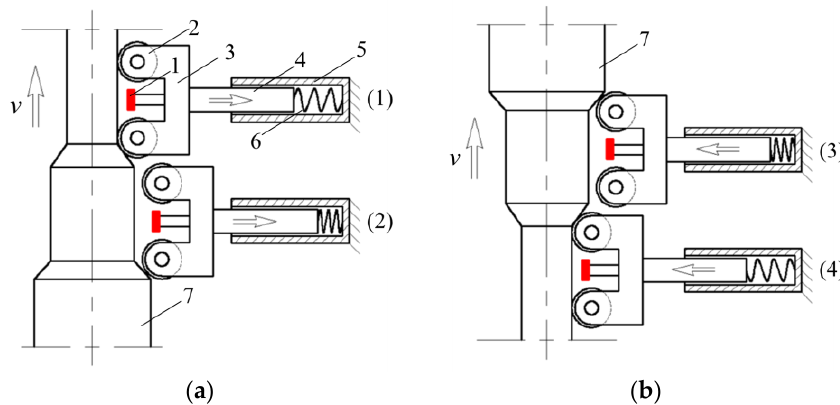
Figure 13. The follow-up scheme for the lift-off-tolerant MFL probing system. 1: probe; 2: wheel; 3: